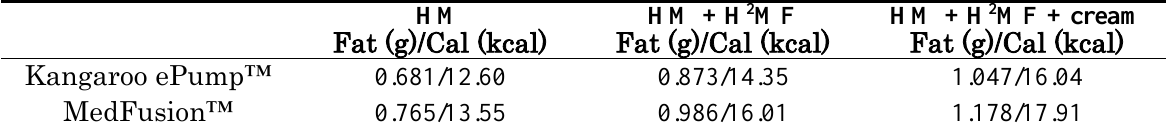
Table 2. Total fat/calories delivered over 20 mL, one-hour feeds (calculated with right-handed integral approximation).